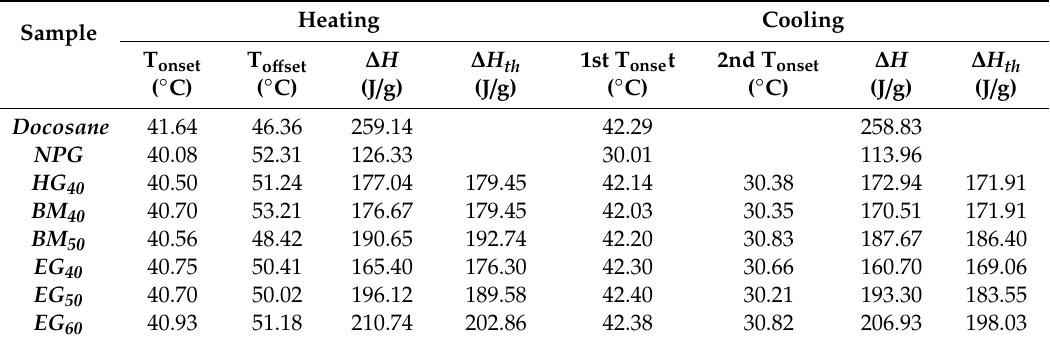
Table 3. True density and apparent bulk density of the stable